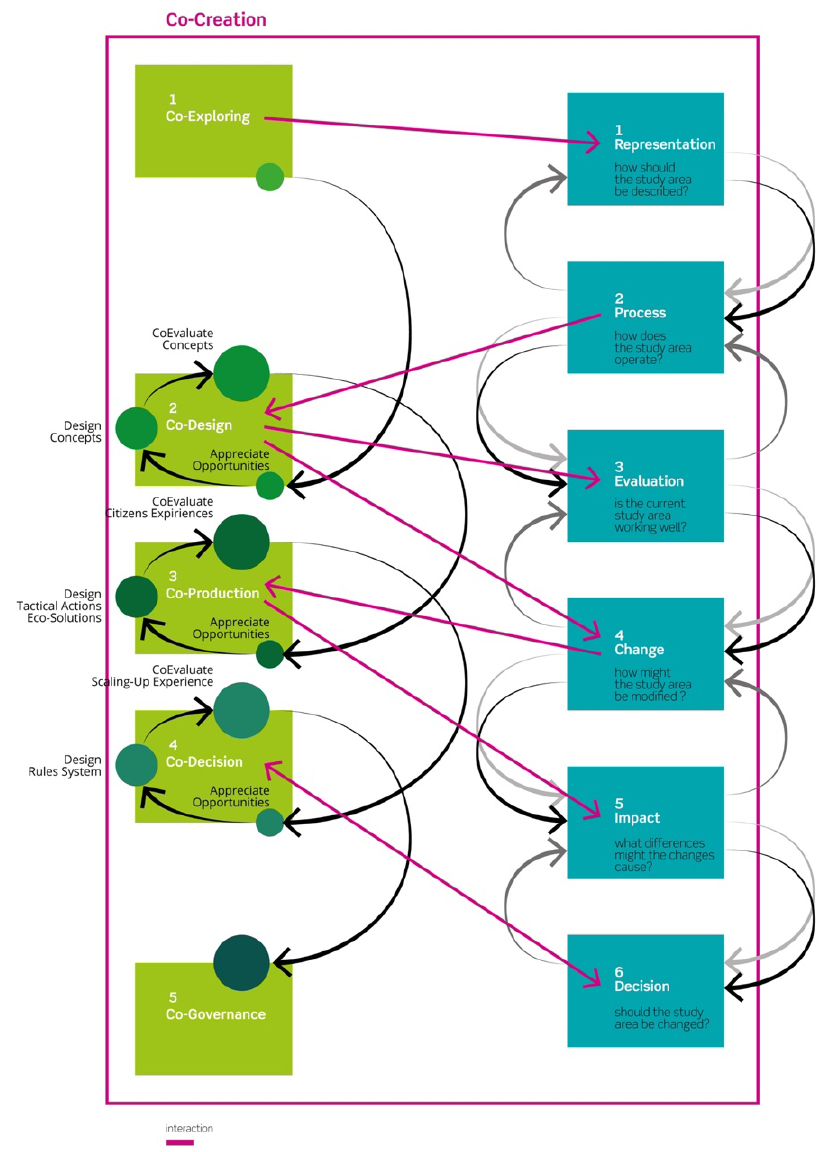
Figure 1. LL & Geodesign interaction: REPAiR methodological proposal. Source: REPAiR Unina